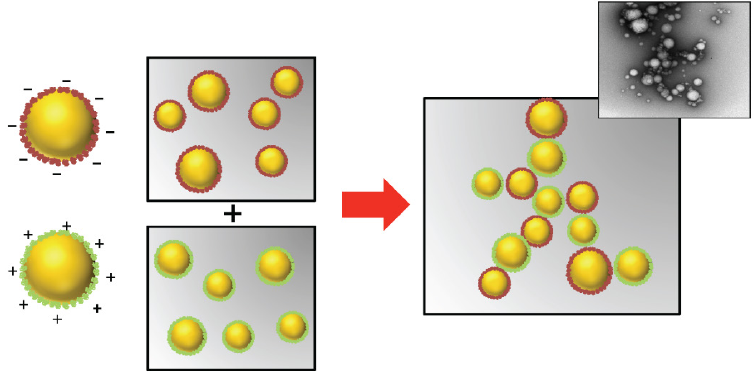
Figure 7. The physicochemical and functional properties of oil-in-water emulsions may be altered after homogenization by using controlled droplet aggregation methods. In this case oppositely charged droplets are made to aggregate through electrostatic attraction. The inset shows an electron microscopy